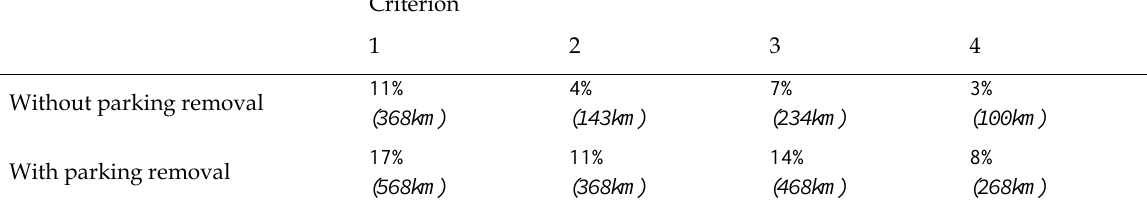
Table 2. Combinations of desirable and acceptable lane width criteria for cycle lane